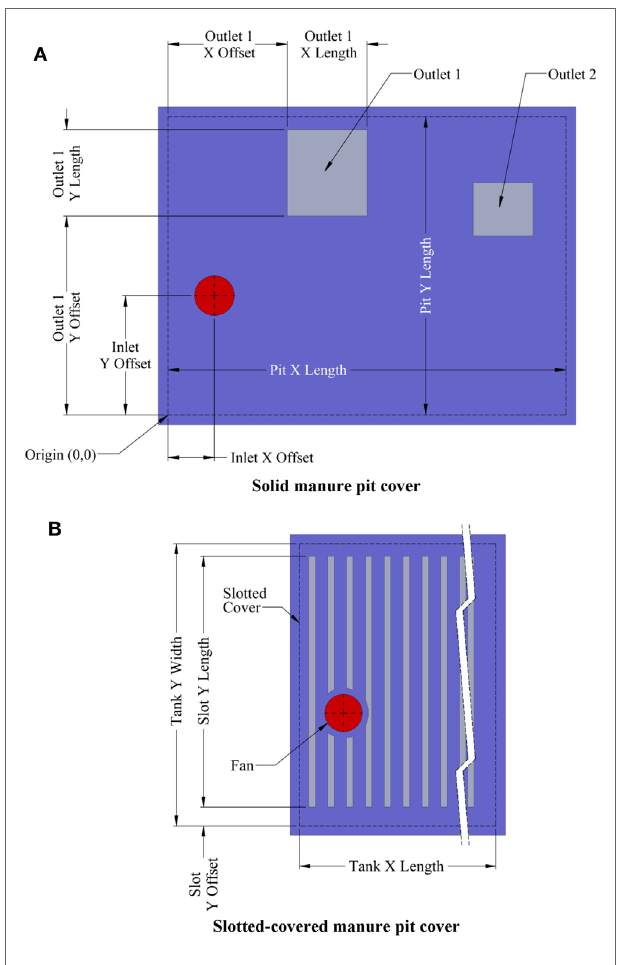
FIgURe 5 | Definition sketches for inputs for (A) solid manure pit covers and (B) slotted-covered manure pit covers